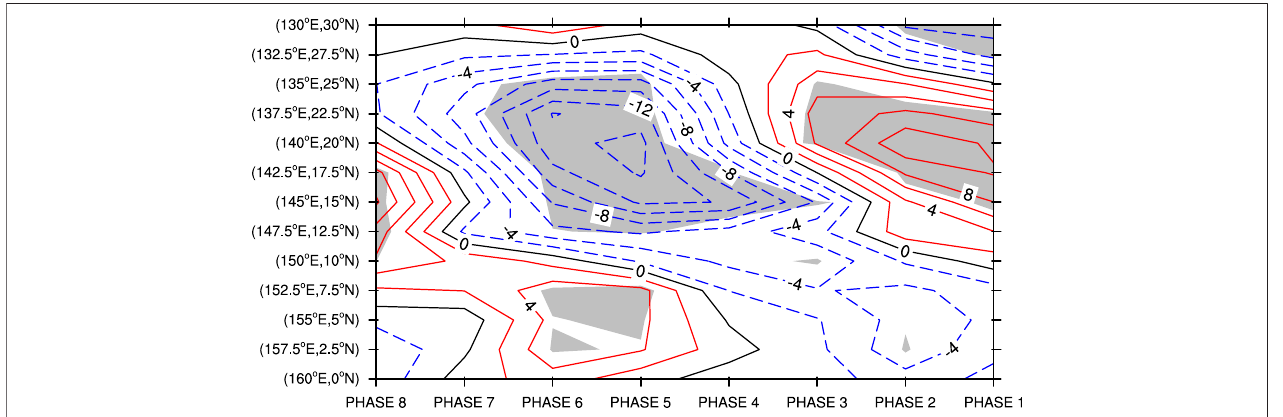
FIGURE 10 | As in Figure 4 , but for the evolution of OLR (unit: W/m 2 ) along a tilt section from (160 ° E, 0 ° N) to (130 ° E, 30 ° N).